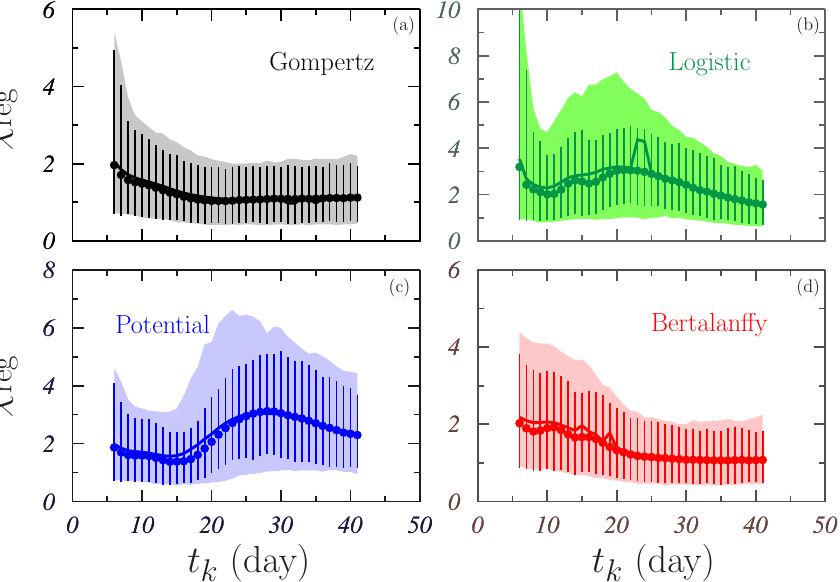
Figure 7. Values of χ reg obtained in the fits of the four mathematical models considered to the simulated MTS volume data { V i , i = k , . . . k + 19 } with k varying between 6 and 41. Solid circles represent the average values and uncertainty bars indicate that corresponding to the 95% CI calculated for the 1000 spheroids in sample #1. The solid curves and the light color areas indicate the same but for sample #2. The results obtained for the Gompertz ( a ), logistic ( b ), potential ( c ) and Bertalanffy ( d ) models are